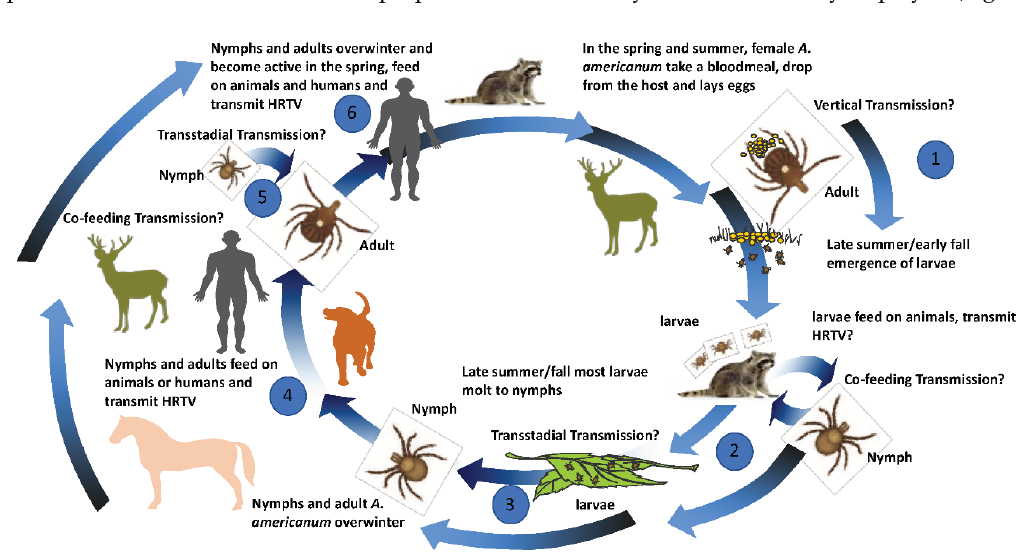
Figure 4. Proposed transmission model for the Heartland virus. Proposed transmission cycle for HRTV between multiple life stages of A. americanum and various vertebrate hosts. (1) Adult A. americanum feed on white-tailed deer and become infected or were previously infected and possibly vertically pass HRTV infections to larvae. (2) Larvae feed on middle-sized mammalian hosts and possibly transmit HRTV or become infected while co-feeding on hosts with HRTV larvae or ticks of different life stages. (3) Larvae possibly transstadially passage HRTV to nymphal stage. (4) Nymphs and adult infected transstadially or by co-feeding possibly transmit HRTV to humans, middle- or large-sized mammalian hosts. (5) Co-feeding or transstadial transmission could occur from nymphal to adult stage. (6) Overwintering of infected nymphal or adult stages could occur with possible transmission in the